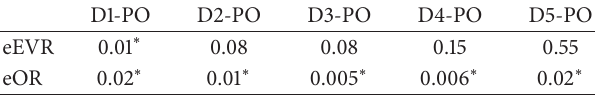
Table 3: Within group comparison of serum urea levels at each postoperative time point as compared to the PO. The numbers in the table represent the 𝑃 values (Wilcoxon signed ranks test).